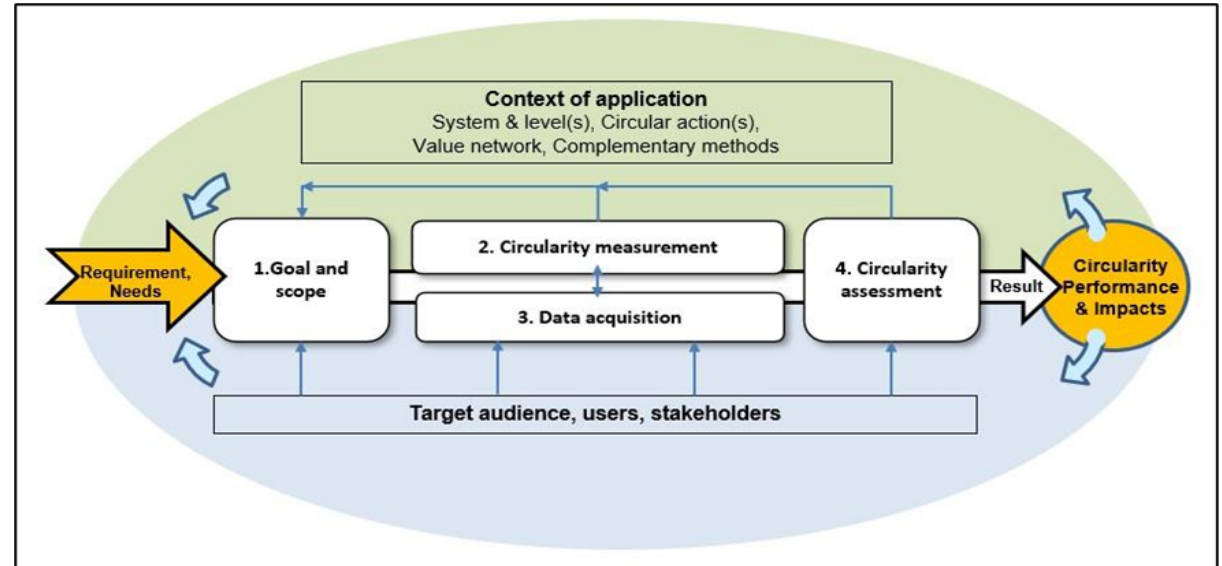
Figure 1. ISO framework for measuring and assessing circularity (Source: ISO Standard